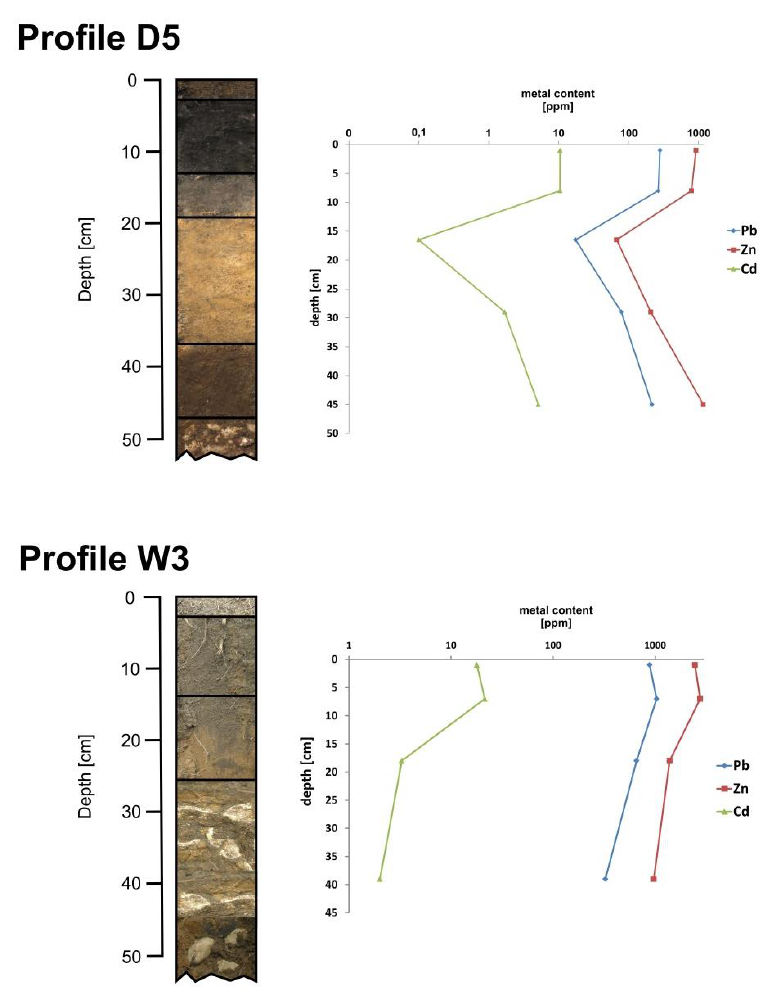
Figure 3. Characteristic examples of studied soil profiles in elevated- (profile D5) and buried (profile W3) ore-bearing dolomitic areas (photographs: T. Hulok).